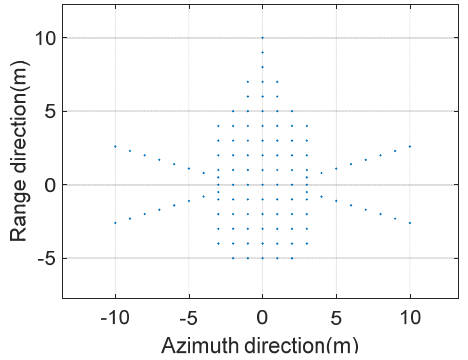
Figure 7. Satellite scattering point simulation model.